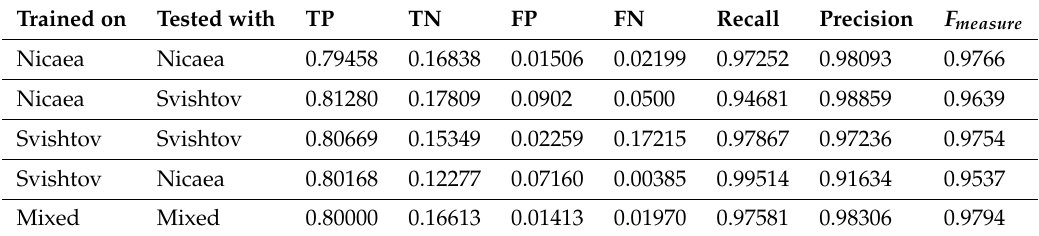
Table 5. True positive, true negative, false positive, false negative, precision, recall, and F measure results are presented for five different models. The results are obtained for individual objects versus